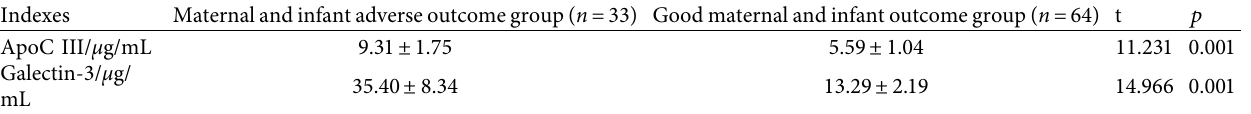
Table 1: Test results of ApoC III and galectin-3 levels in blood of subjects.